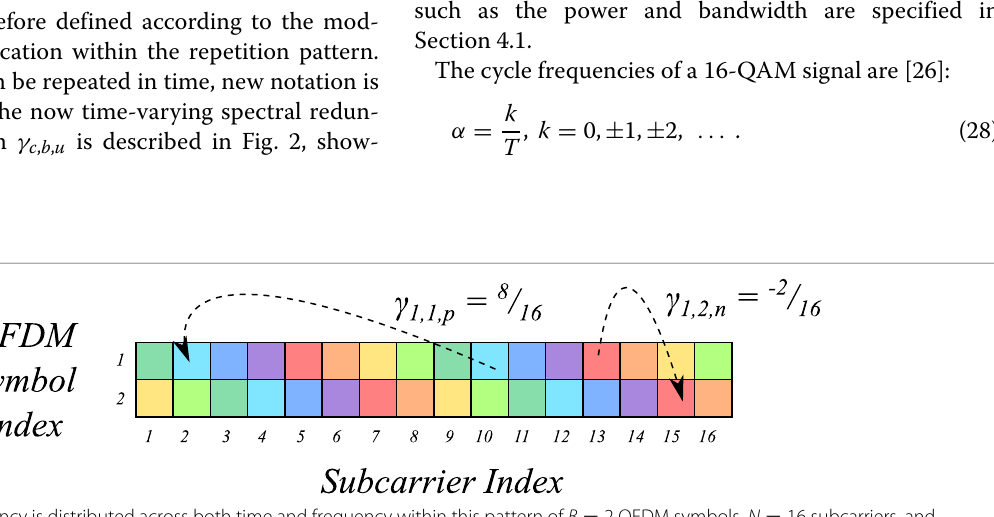
Fig. 2 Spectral redundancy is distributed across both time and frequency within this pattern of B = 2 OFDM symbols, N = 16 subcarriers, and M = 8 data-symbols. Three CFs illustrate the time-varying spectral redundancy. The arrows indicate in which direction the FS is